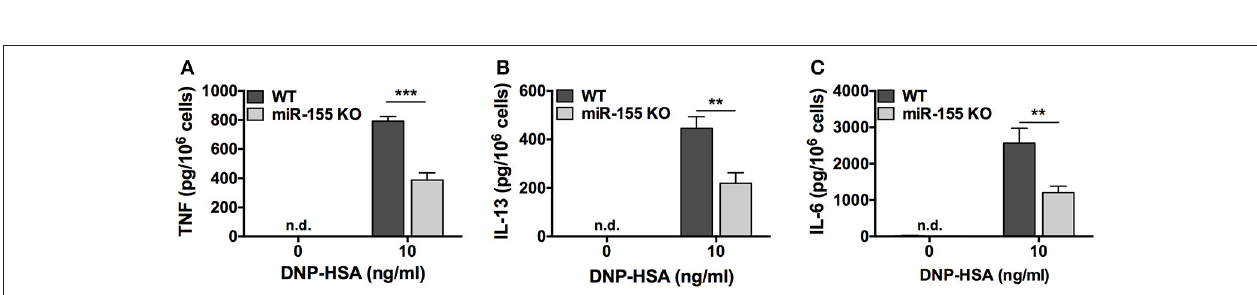
FIGURE 5 | Fc ε RI-induced cytokine production is impaired in miR-155 KO BMMCs. Wild-type and miR-155 KO BMMCs were sensitized with anti-DNP-IgE and challenged with multivalent antigen DNP-HSA for 24h. Secreted TNF (A) , IL-6 (B) , and IL-13 (C) in supernatant were measured by commercial ELISA. The bar graphs represent mean ± SEM of values obtained from independent experiments with three different BMMC cultures from different mice. Cytokines in untreated samples were generally below the level of detection. Lowest level of detection for TNF, IL-6, and IL-13, respectively, were 31.2, 15.6, and 62.5 pg/ml. n.d., not detected. Significance was determined with Student’s t -test. ** p < 0.01; *** p < 0.001.